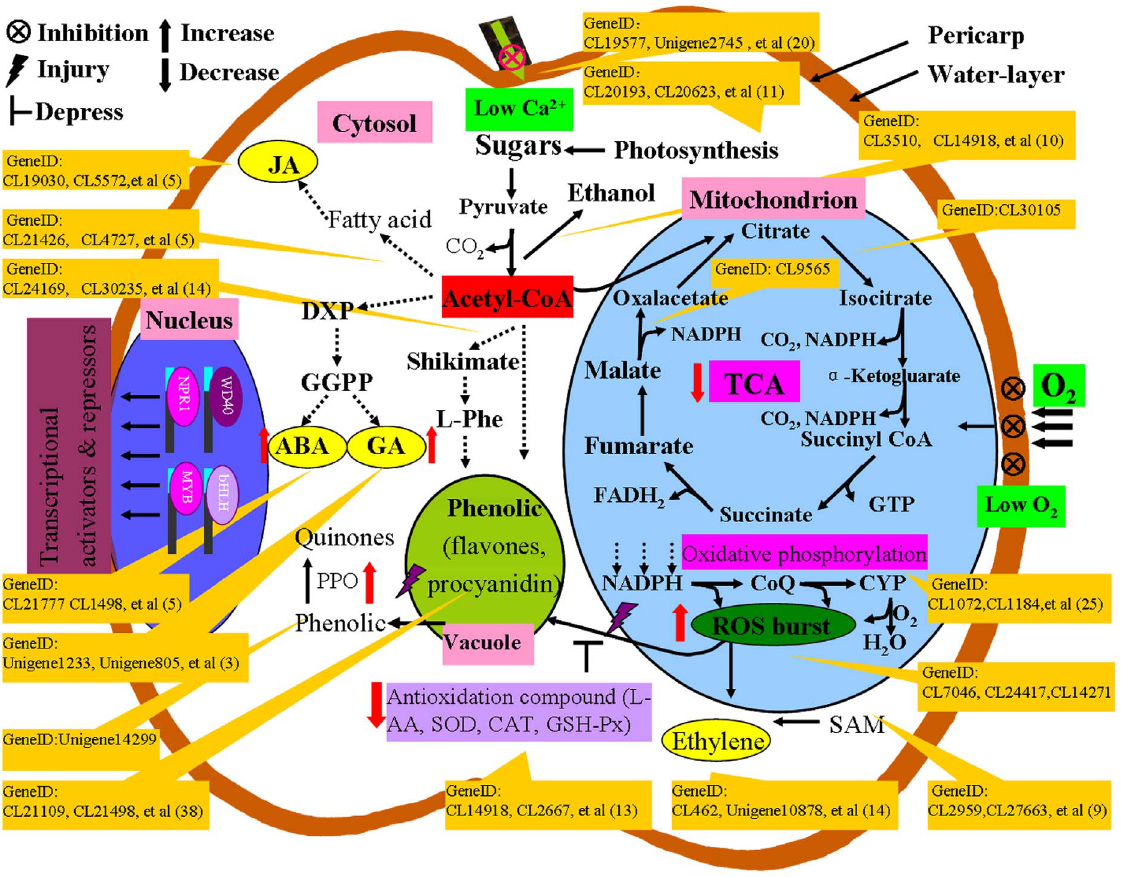
Figure 6. Overview of the major metabolic pathways involved in brown spots disease (SBS). The genes are designated according to their gene ID number, and the detailed gene information can be viewed in additional file Table S3. JA, jasmonic acid, ABA; abscisic acid; GA, gibberellic acid; SAM, S-adenosyl methionine; PPO, polyphenol oxidase.